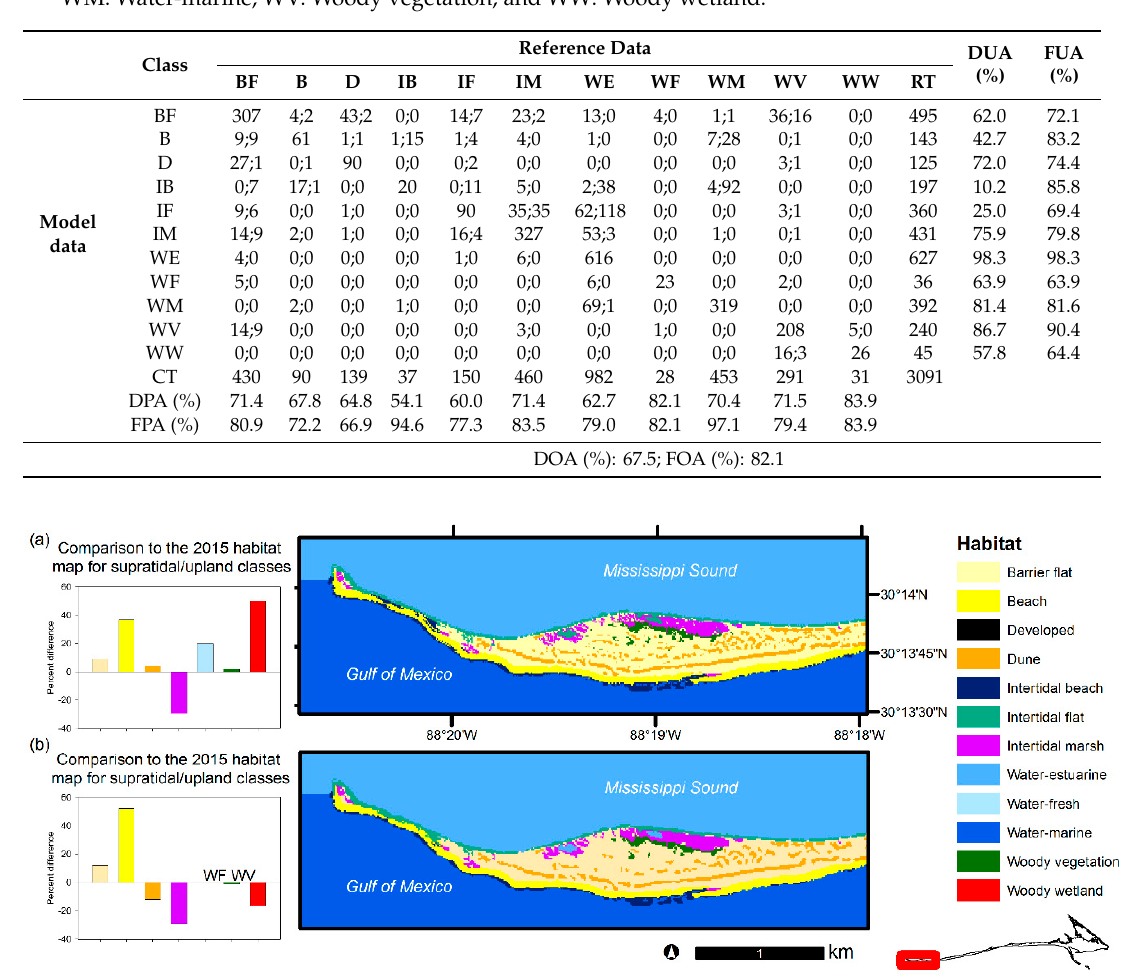
Table 2. Error matrix with deterministic and fuzzy accuracies for the final contemporary model results (i.e., with post-processing and a four-pixel minimum mapping unit) for Dauphin Island, Alabama, USA. For the o ff -diagonal cells, the first value indicates deterministic count, and the second value indicates the fuzzy count. BF: Barrier flat; B: Beach; CT: Column total; D: Dune; DPA: Deterministic